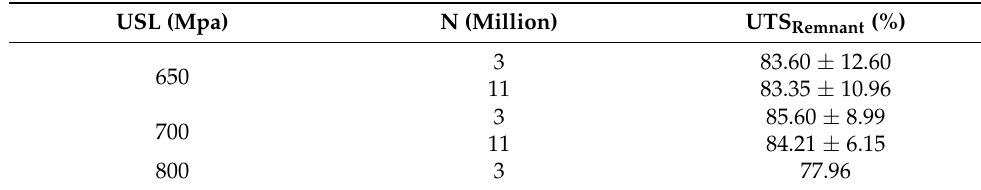
Table 6. Average remnant strength of the straps at 650, 700 and 800 Mpa USL. USL (Mpa) N (Million) UTS Remnant (%)